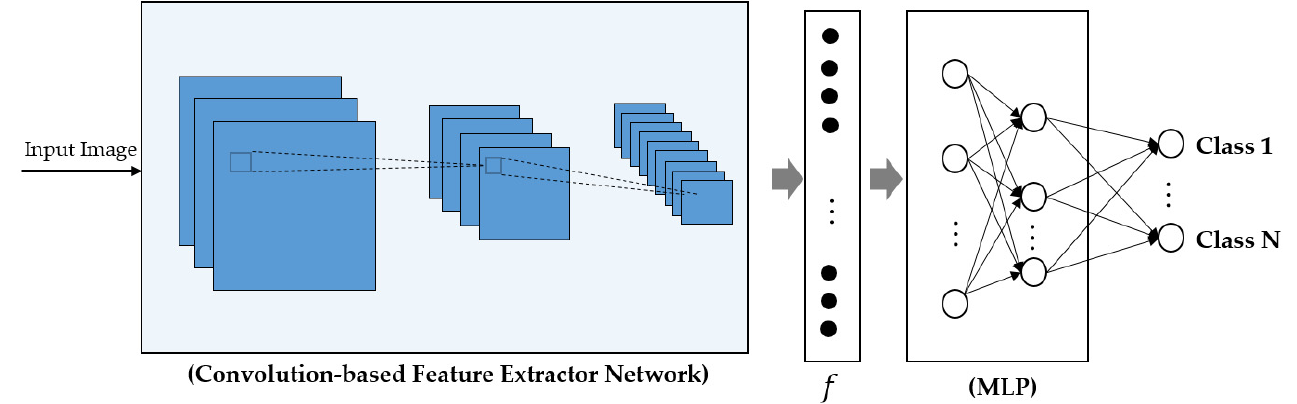
Figure 3. Methodology of the CNN-based method for the classification problem.